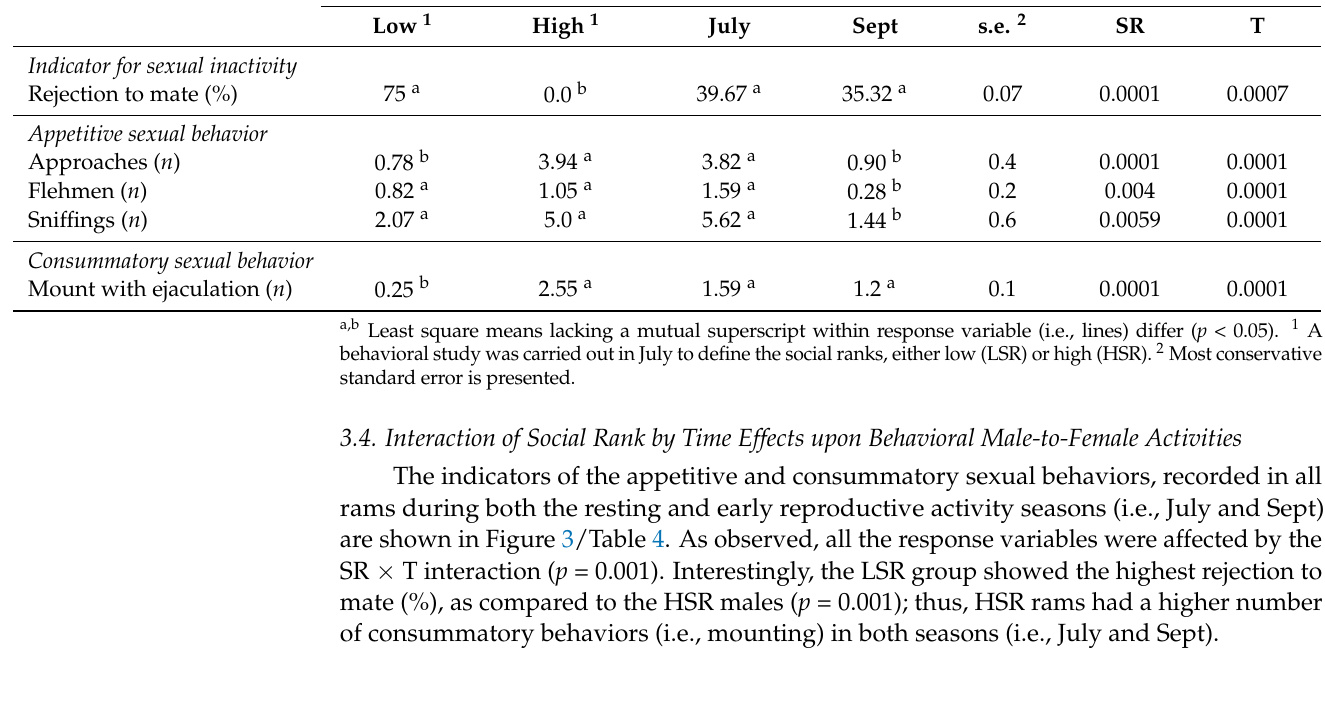
Table 3. Least square means ± standard error of single effects for the sexual male-to-female interaction considering the variables of rejection to mate, approaches, flehmen, anogenital sniffing, and mounting, according to time (T; i.e., reproductive arrest—July or early reproductive season—Sept) and either low ( n = 15) or high ( n = 9) social rank in Dorper rams ( n = 24) in northern Mexico (25 ◦ N) 1,2 . Social Rank (SR) Time